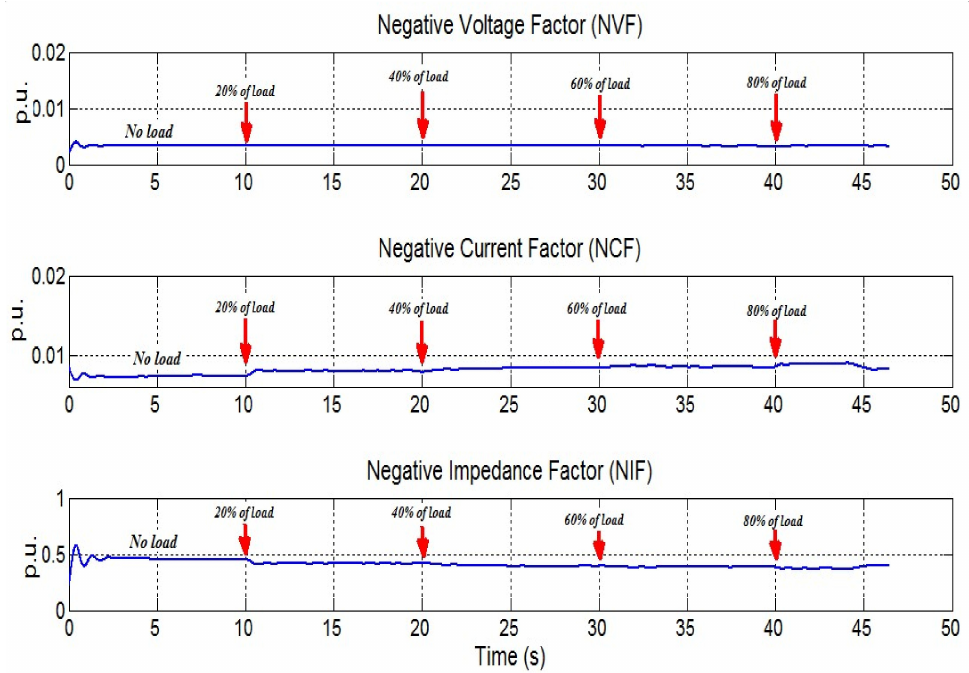
Figure 9. The studied factors for a balanced supply condition, under different step load